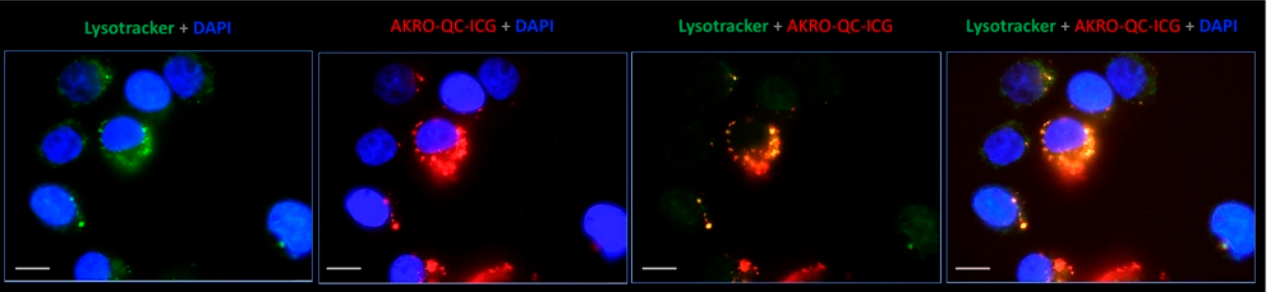
Figure 1. AKRO-QC-ICG accumulates in lysosomes and becomes fluorescent in the human BCa cells in vitro. Representative live cell fluorescence microscopy images of the human breast MDA-MB-486 cancer cell monolayer incubated for 30 min with 1 μ M of quenched substrates followed by washout. ICG fluorescence of probe is false-colored red, lysotracker (lysosome selective stain) is false colored green, blue is DAPI (nuclear stain), and yellow/orange corresponds to lysosome/ICG co-localization. Magnification—100× with immersion (Leica-DM4000B). Scale bar—10 μ m.